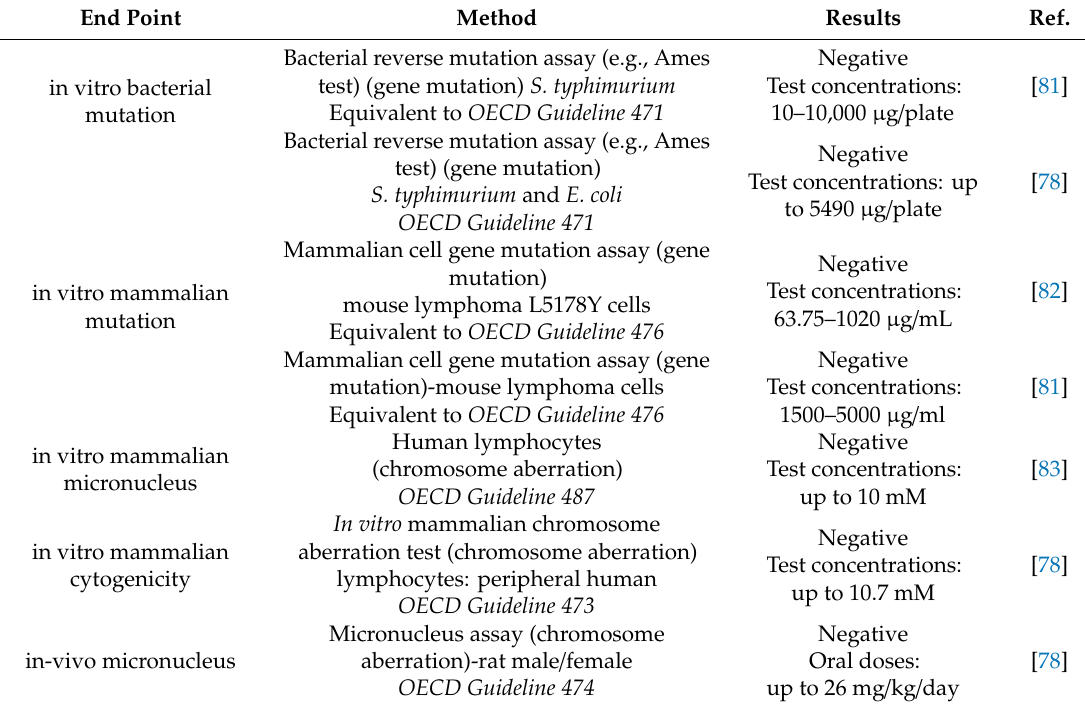
Table 7. Summary of genotoxicity